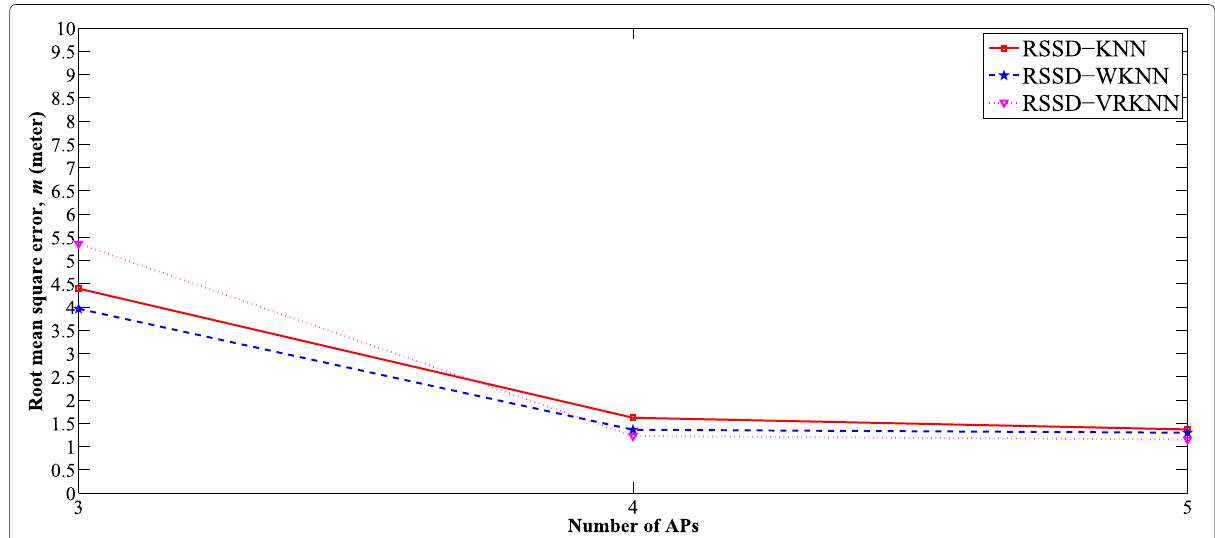
Fig. 14 RMSE comparison among RSSD-KNN, RSSD-WKNN, and RSSD-VRKNN. The number of APs various from 3 to 5 with 100 positioning targets